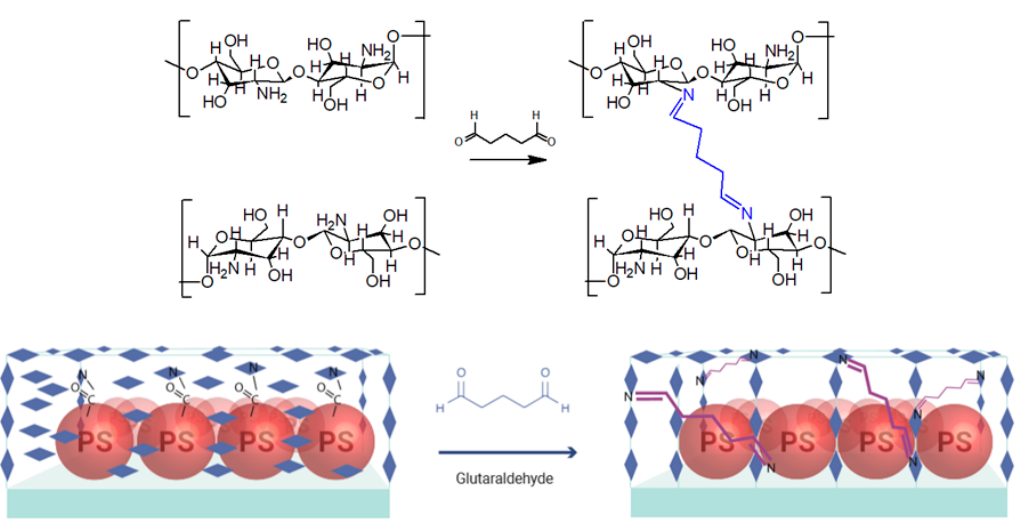
Figure 6. Scheme of the crosslinking of chitosan with glutaraldehyde.